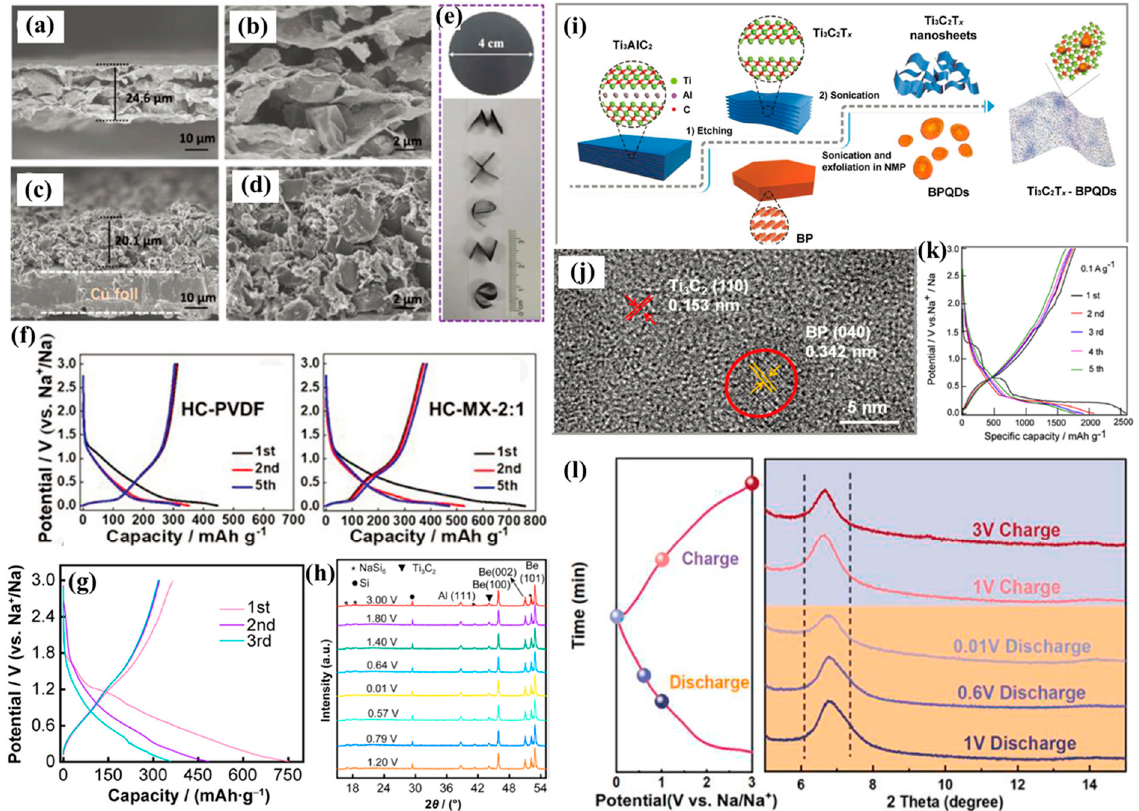
Figure 4. SEM images of ( a , b ) HC/MXene (HC-MX-2:1) and ( c , d ) HC/PVDF electrodes; ( e ) digital photo of flexible HC/MXene film and shaped “MXene” letters. ( f ) The discharge–charge profiles of HC/PVDF and HC/MXene electrodes at 30 mA/g (reproduced with permission from Ref. [69]; copyright 2019, Wiley-VCH). ( g ) Discharge–charge profiles and ( h ) ex situ XRD patterns of different states for Si/Ti 3 C 2 composites (reproduced with permission from Ref. [72]; copyright 2022, Springer). ( i ) Schematic of the formation process and ( j ) HRTEM image of a BPQD/Ti 3 C 2 T x composite (reproduced with permission from Ref. [55]; copyright 2018, Wiley-VCH). ( k ) Initial five discharge–charge profiles of PDDA-BP/Ti 3 C 2 heterostructures (reproduced with permission from Ref. [73]; copyright 2019, Elsevier). ( l ) Ex situ XRD patterns of sandwich-like MXenes between PEI polymer networks (reproduced with permission from Ref. [74]; copyright 2023, Elsevier).